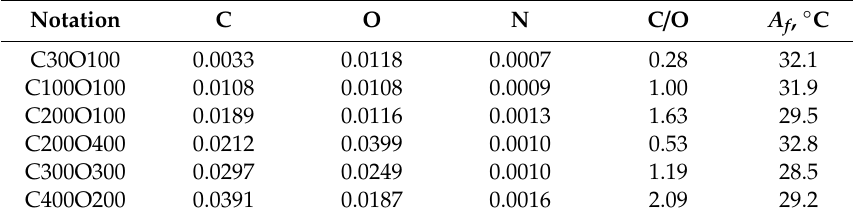
Table 1. Chemical compositions (mass%) and A f temperature of Ti-Ni